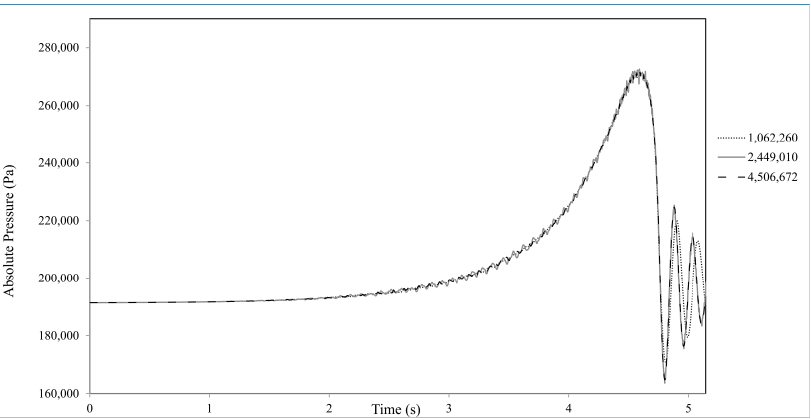
Figure 7. Average absolute pressure monitoring at section 11 m upstream of valve for three different grids.